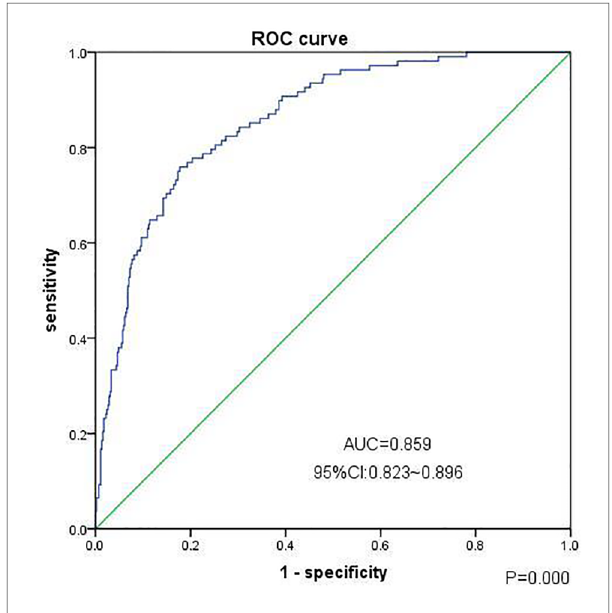
FIGURE 1 Clinical prediction model (ROC curve) for the progression of chronic kidney disease in patients 90 days after CS-AKI. Note: The Goodness of Fit Hosmer-Lemeshow test, Chi-square value 5.693, P =0.682, cutoff value=0.226, n p <cutoff =401, n p ≥ cutoff